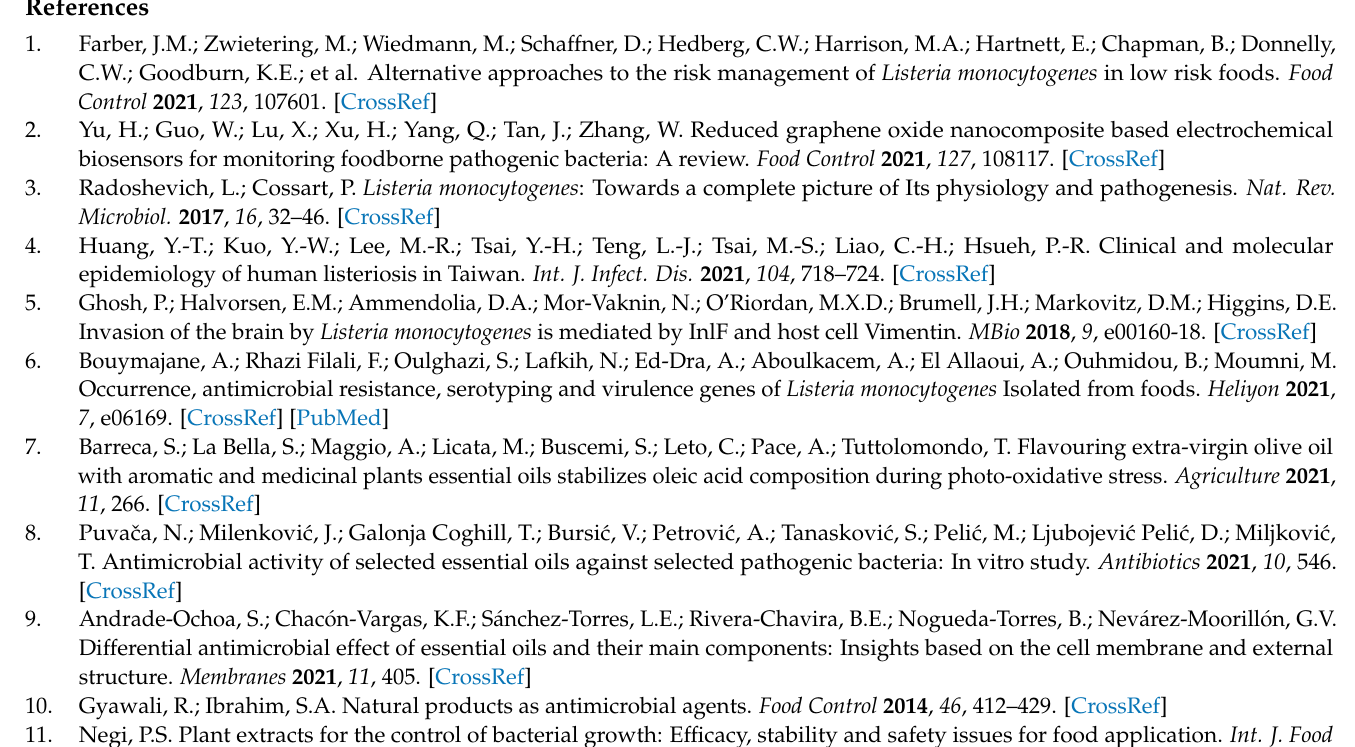
10.3390/foods10123006/s1, Figure S1: Clustering analysis for selecting the MDR L. monocytogenes strains., Figure S2. Incidence of resistance and virulence gene in MDR L. monocytogenes strains. Table S1: Antimicrobial agents, zone and interpretive chart., Table S2. PCR Primers and references for 16S rRNA of L. monocytogens and virulence genes., Table S3. PCR Primers and references for 16S rRNA of Listeria and virulence